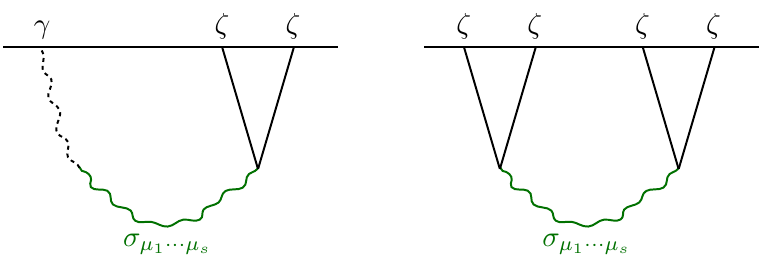
Figure 2 . Tree-level diagrams contributing to